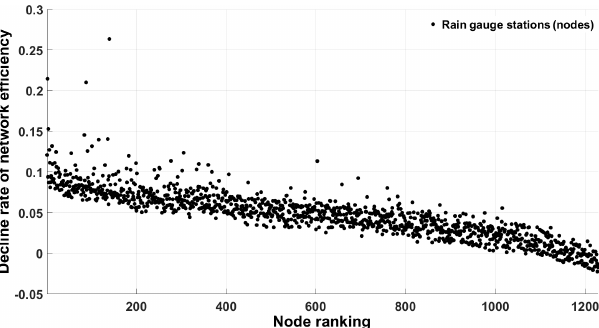
Figure 5. Decline rate of network efficiency corresponding to the removal of each node in the rainfall network. In each implemen- tation, only one node is removed from the network according to ranking with replacement